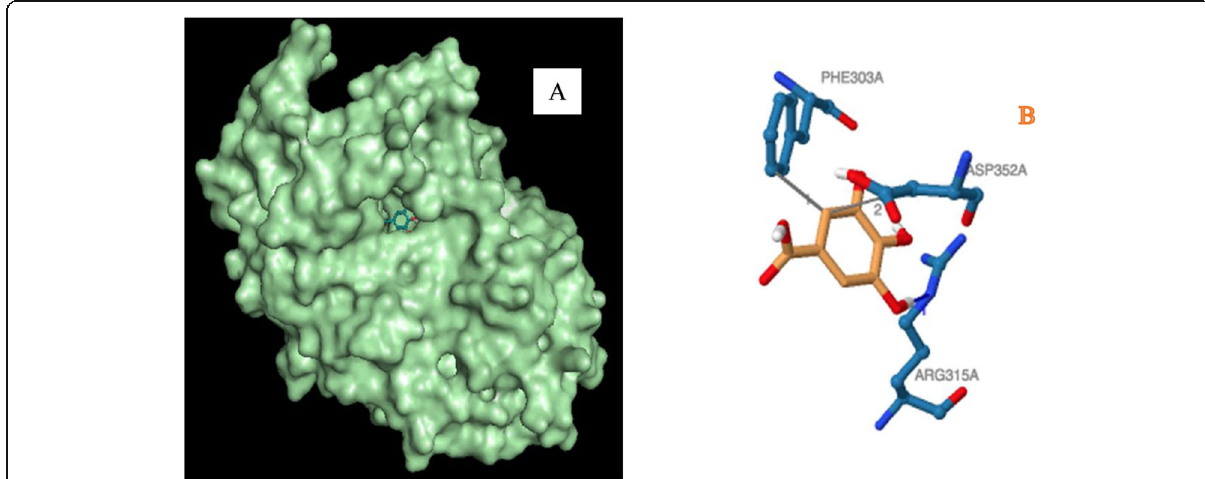
Fig. 3 Binding pose and binding site of gallic acid with α -glucosidase (panel A), molecular interaction of gallic acid with amino acid residues within the binding pocket of the protein structure (panel B)